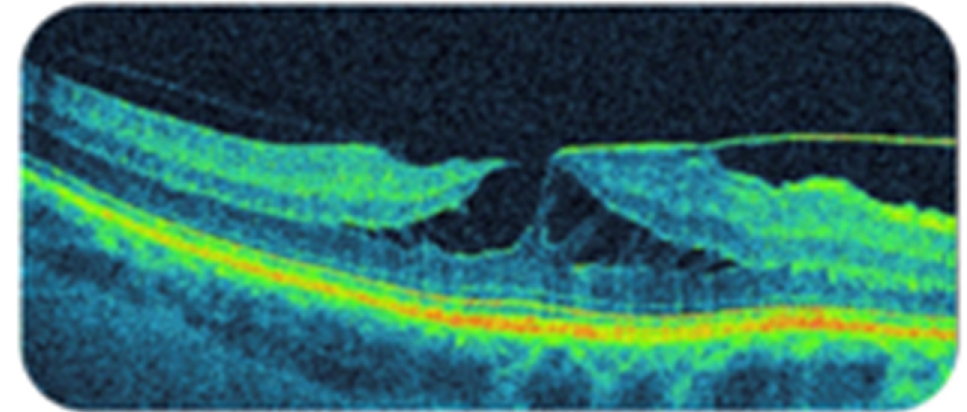
Figure 1. A lamellar macular hole. The presented image is an LMH with a major tractional component, with a “moustache” appearance, according to Govetto et al.